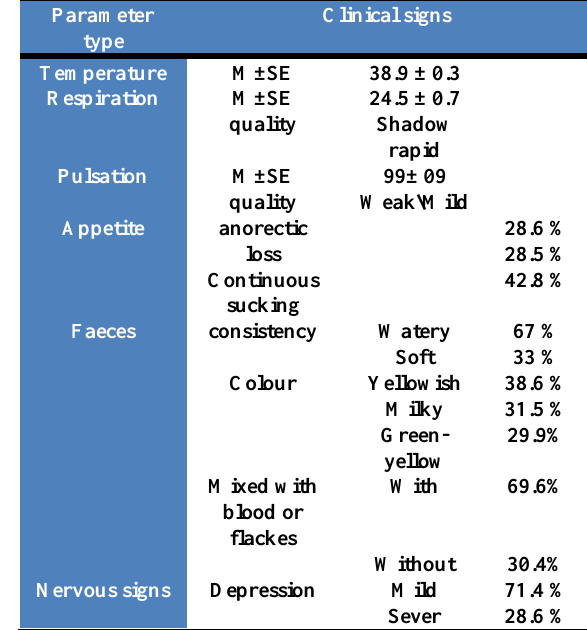
Table, 3: The main clinical signs of rotaviral diarrheic